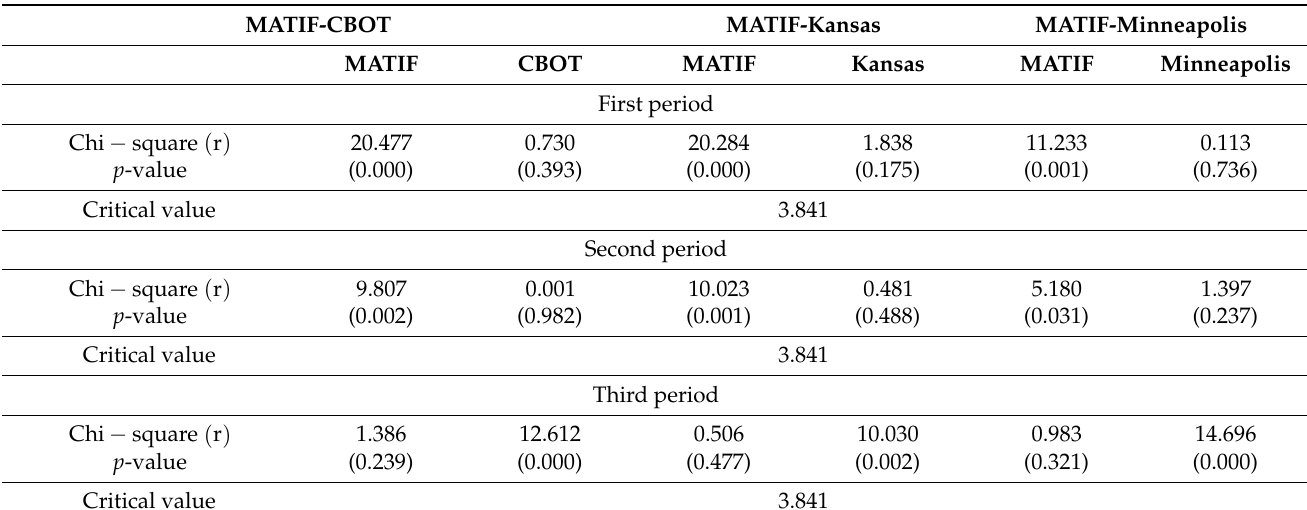
Table 4. A Chi-square test of weak